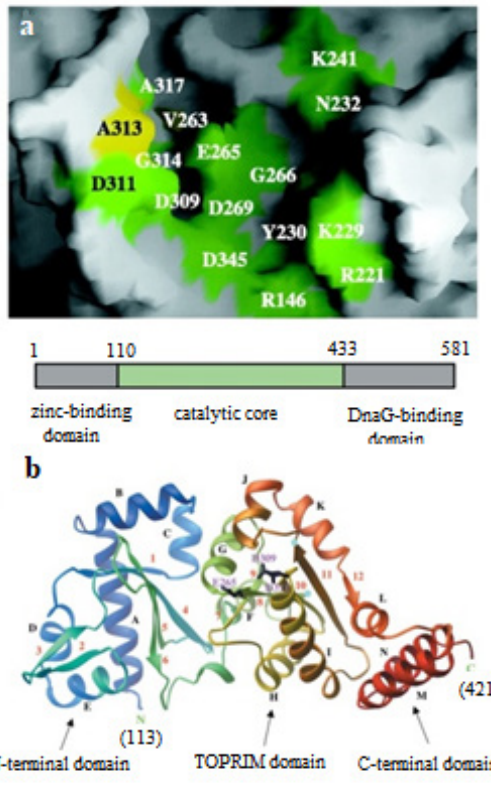
Figure 3 - ( a ) Proposed active-site of DnaG and the residues include, ( b ) Structure of